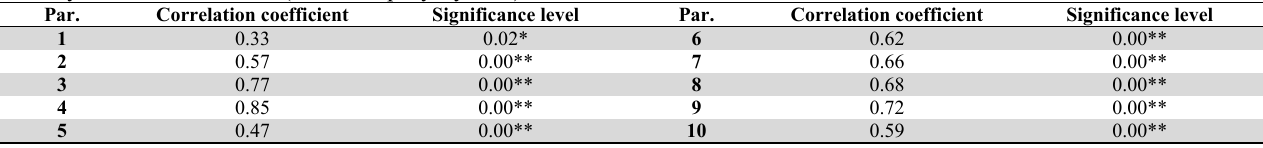
Validity of the First Section (Credit Inquiry